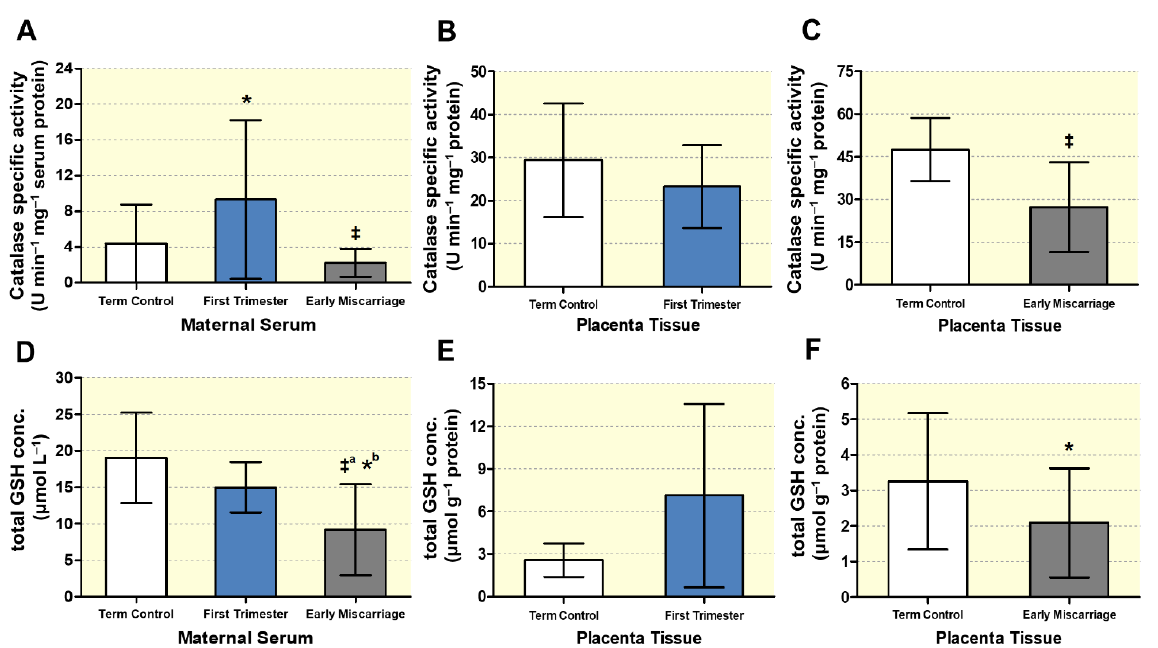
Figure 6. Analysis of enzymatic antioxidant capacity . Catalase activity was measured in ( A ) maternal serum of EMC patients ( n = 20) and first trimester and term controls ( n = 20, n = 19), placentae from ( B ) first trimester and term controls ( n = 6 and n = 5, respectively; Swiss cohort), and ( C ) placentae from EMC patients and term controls ( n = 20 and n = 19, respectively). Total glutathione (GSH) levels were determined in ( D ) maternal serum of EMC patients ( n = 20) and first trimester and term controls ( n = 20 and n = 19, respectively), ( E ) placentae of first trimester and term controls ( n = 6 and n = 5, respectively; Swiss cohort), and ( F ) placentae of EMC and term control ( n = 20 and n = 19, respectively). Data are shown as mean ± SD for each group. For ( A , D ), the statistical differences were analyzed using Kruskal – Wallis test followed by Dunn ’ s multiple comparison test. For ( B , E ) and ( C , F ), statistical analysis was performed by using unpaired two-tailed Mann – Whitney test for comparing first trimester vs. term controls (Swiss cohort) and EMC vs. term controls, respectively; ‡ ( p ≤ 0.001), * ( p ≤ 0.05), ‡: significance between EMC and first trimester; ‡ a : significance between EMC and term control;